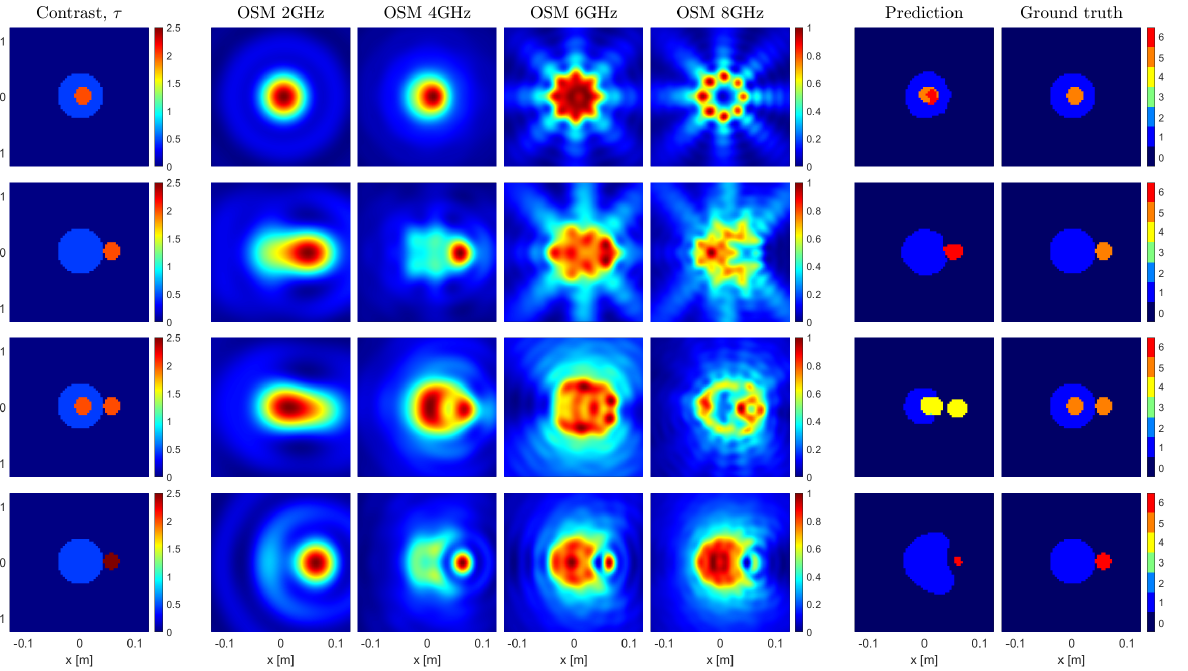
Figure 4. Imaging results of 4 experimental cases. The first column depicts the contrast of the imaged samples. The following 4 columns represent the OSM indicators at 2, 4, 6, and 8 GHz. The 6th and 7th column show the predictions made by the U − Net and their corresponding ground truths,